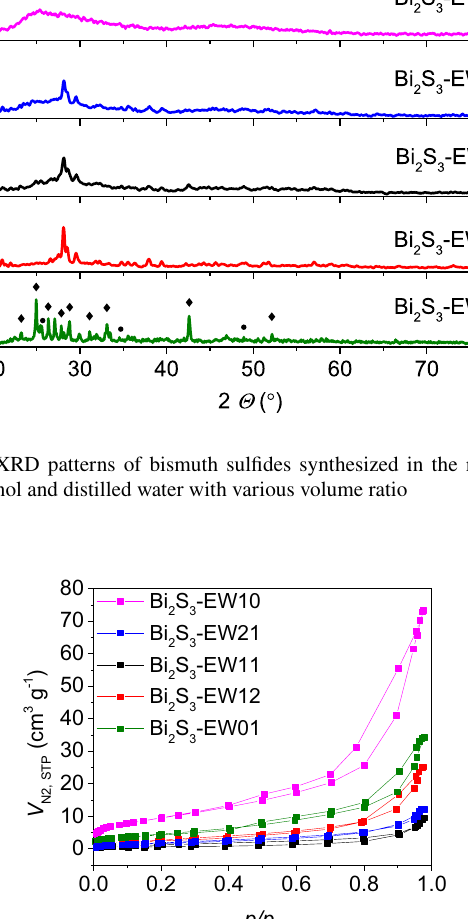
Table 1 Parameters of the porous structure obtained based on N 2 isotherms for bismuth sulfides obtained in various solvents